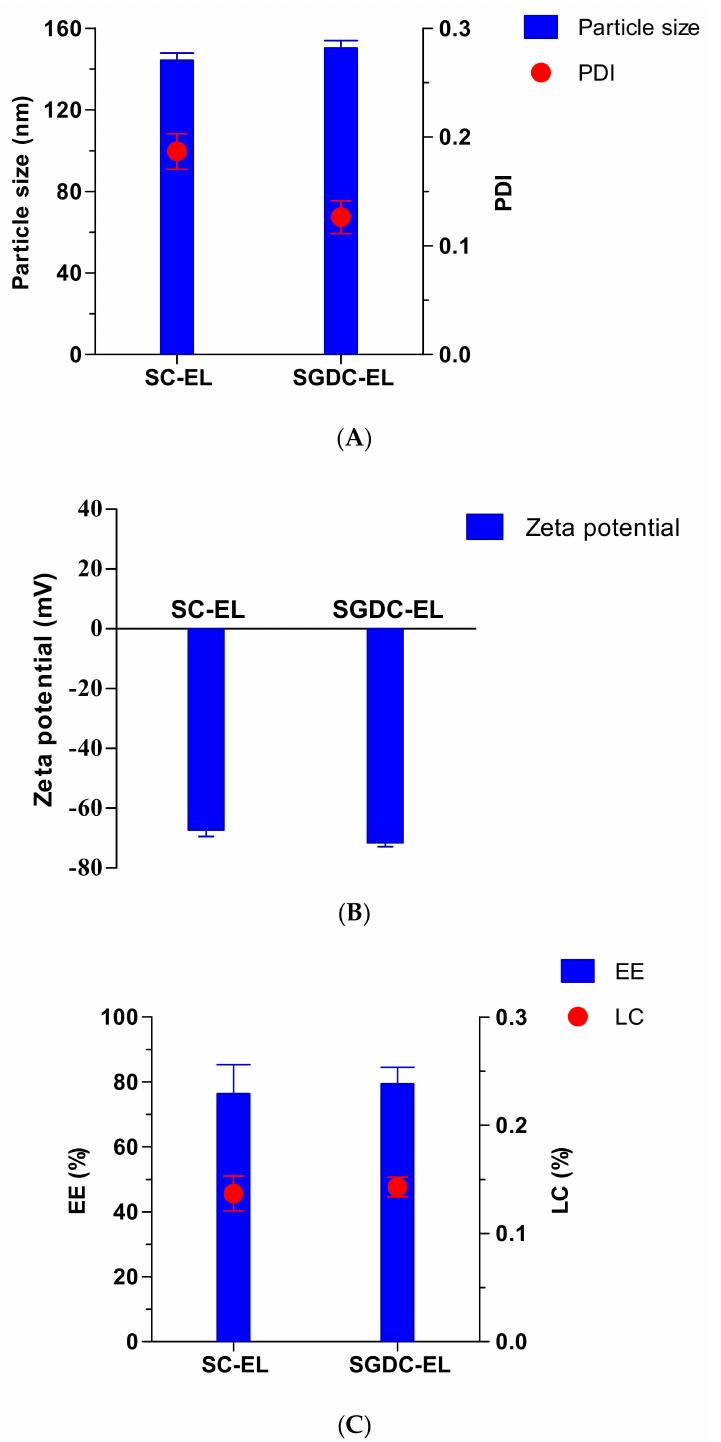
Figure 2. Physical characterizations of the elastic liposomes (SC-EL and SGDC-EL): ( A ) particle size and polydispersity index (PDI), ( B ) zeta potential, and ( C ) entrapment efficiency ( EE ) and loading capacity ( LC ). Data are expressed as mean ± SD ( n =